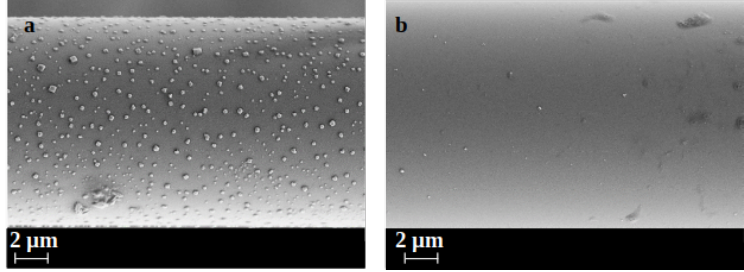
Figure 6. SEM images of two fibers coated with CSB-MMT. Magification 2.00 K × .